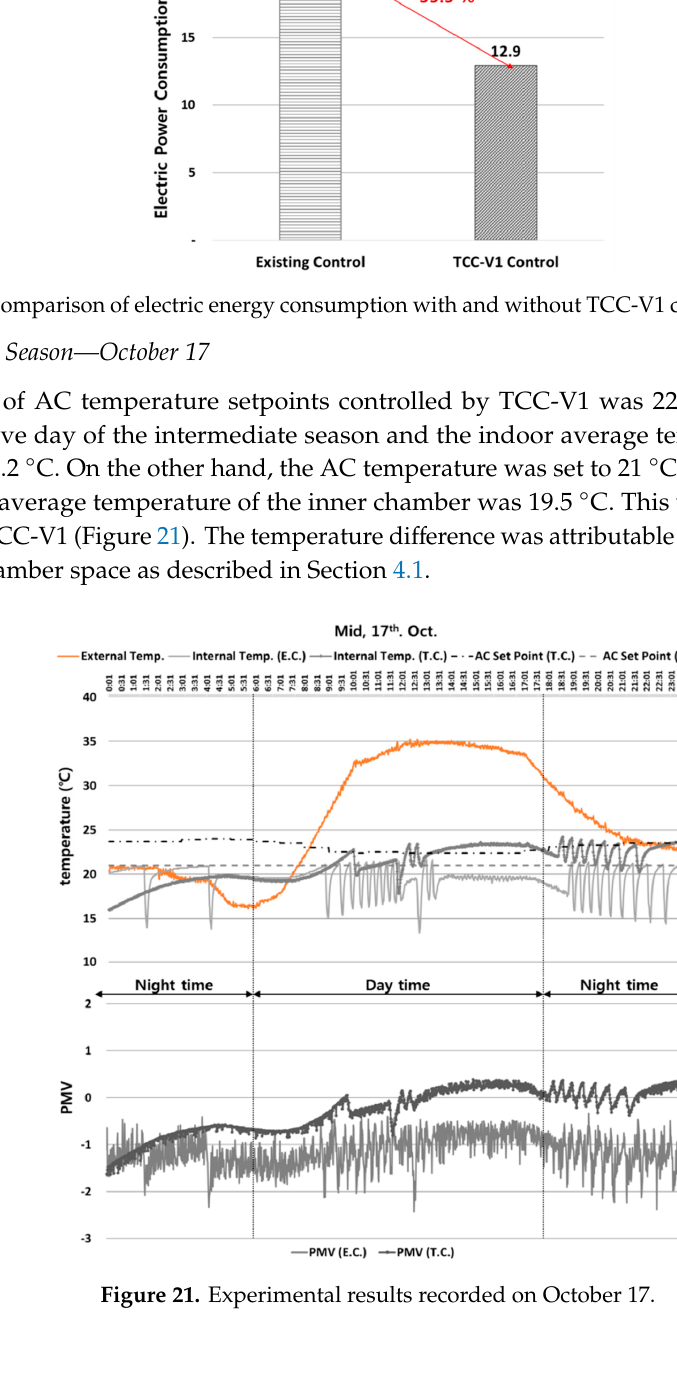
Figure 22. Comparison of electric energy consumption without and with TCC-V1 on October 17. 5.3. Winter Season—January 8 The AC was not operated on January 8, the representative day for the winter season, because the indoor temperature of the inner chamber remained below the AC setpoint temperature (Figure 23). However, the AC still consumed 0.43 kWh of electric energy both with and without the TCC-V1 because of its base load. The outdoor average temperature on January 8 was 13.1 °C and the indoor average temperature was 15.3 °C. The average PMV value was − 0.5 and this indicates that the indoor thermal comfort did not deteriorate, even though the AC was turned off in the winter season.